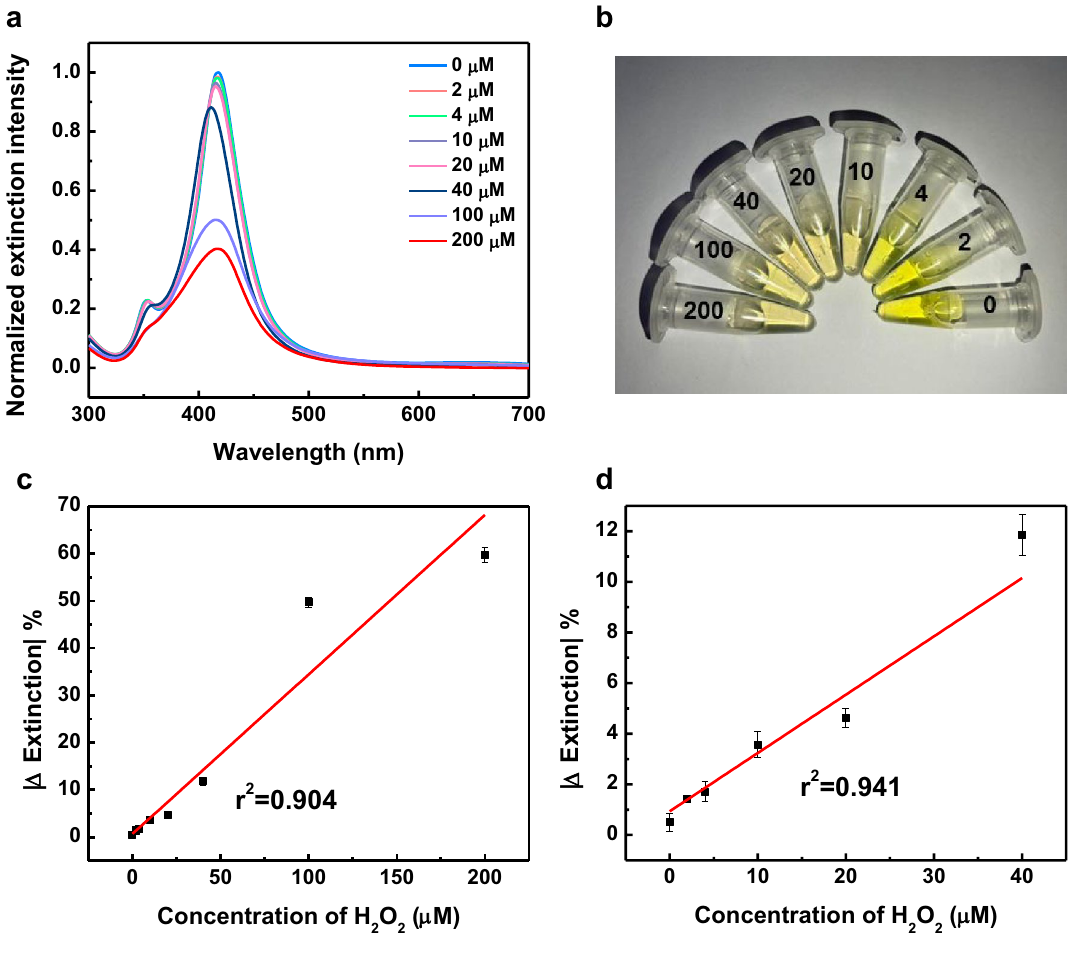
Figure 4. ( a ) UV–Vis extinction spectra of the aqueous suspensions of Au@Ag nanocubes in various concentrations of H 2 O 2 . ( b ) Optical image of the aqueous suspensions of Au@Ag nanocubes in various concentrations of H 2 O 2 (unit: µM). ( c ) Plot shows the changes of extinction intensity of Au@Ag nanocubes as a function of the concentrations of H 2 O 2 ranging from 0 to 200 µM and the linear fitting. ( d ) Plot shows the changes of extinction intensity of Au@Ag nanocubes as a function of the concentrations of H 2 O 2 ranging from 0 to 40 µM and the linear fitting.